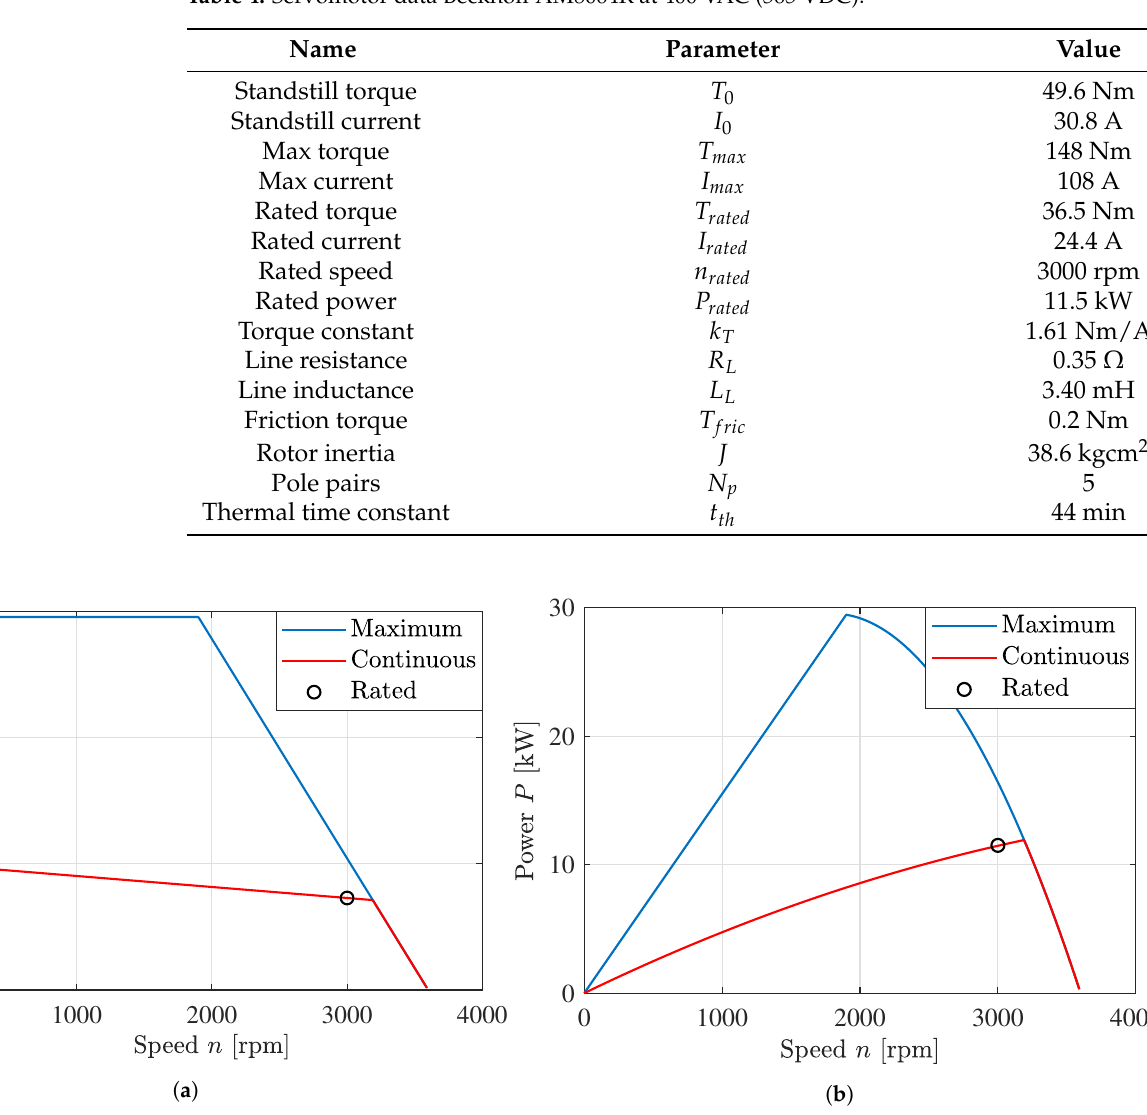
Figure 6. Torque and power curves for the selected motor with maximum, continuous, and rated operation. ( a ) Speed-torque curve; ( b ) Speed-power curve.